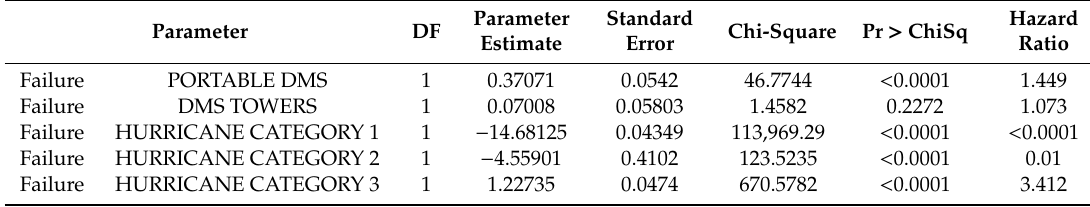
Table 3. Maximum likelihood estimates (DMS